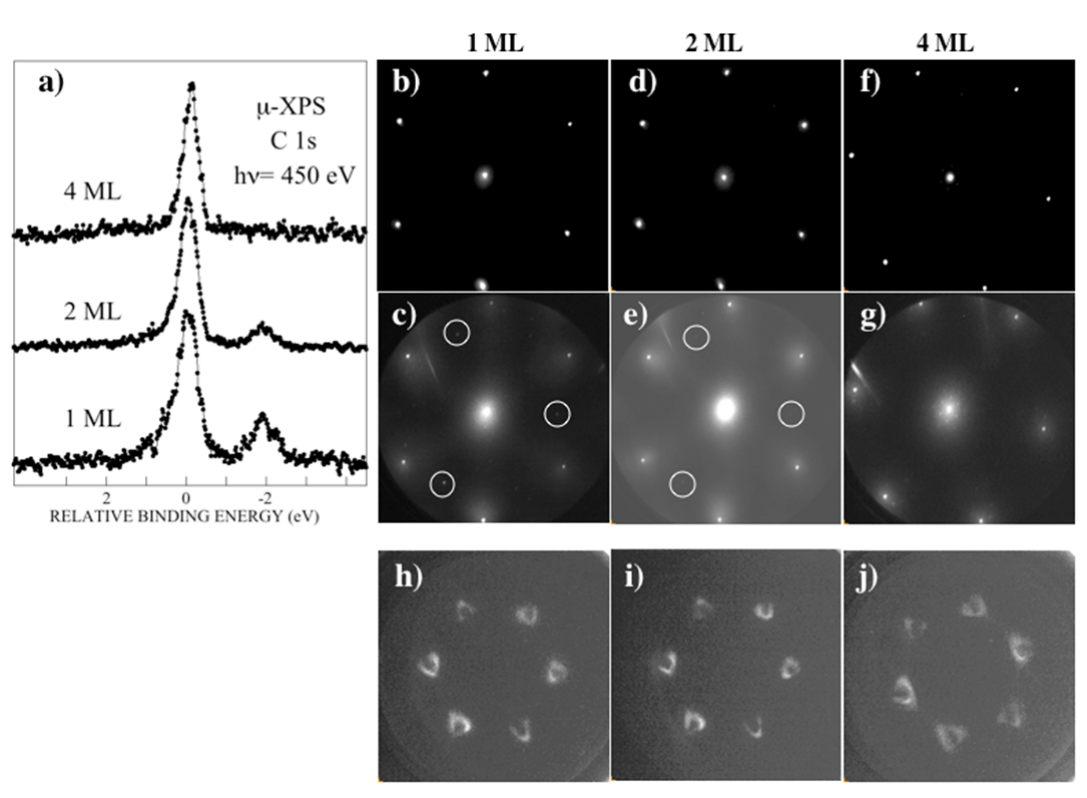
Figure 2. (a ) C 1s spectra collected, using a probing area of 4 μ m, from domains in Figure 1 with different graphene thickness; ( b )–( g ) show 1.5 μ m selected area LEED patterns from; ( b ) and ( c ), the 1 ML domain at 45 and 145 eV; ( d ) and ( e ), the 2 ML domain at 45 and 145 eV; and ( f ) and ( g ), the 4 ML domain at 45 and 130 eV, respectively. In ( h )–( j ), the photoelectron angular distribution pattern (PAD) collected from, respectively, the 1 ML, 2 ML and 4 ML domains are shown. The PADs were collected at an energy of 1.5 eV below the Fermi level, using a probing area of 800